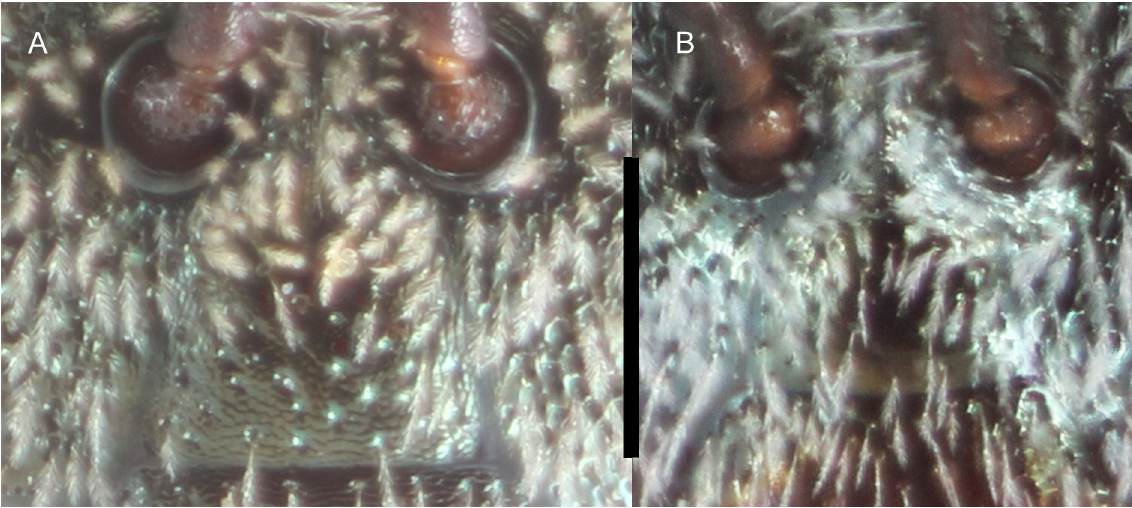
Fig. 101. Supraclypeal area. A . Lasioglossum ( D. ) arenisaltans sp. nov., ♀, mostly tessellate. B . L. ( D. ) mesillense (Cockerell, 1898), ♀, mostly shiny. Scale bar: 0.25 mm.